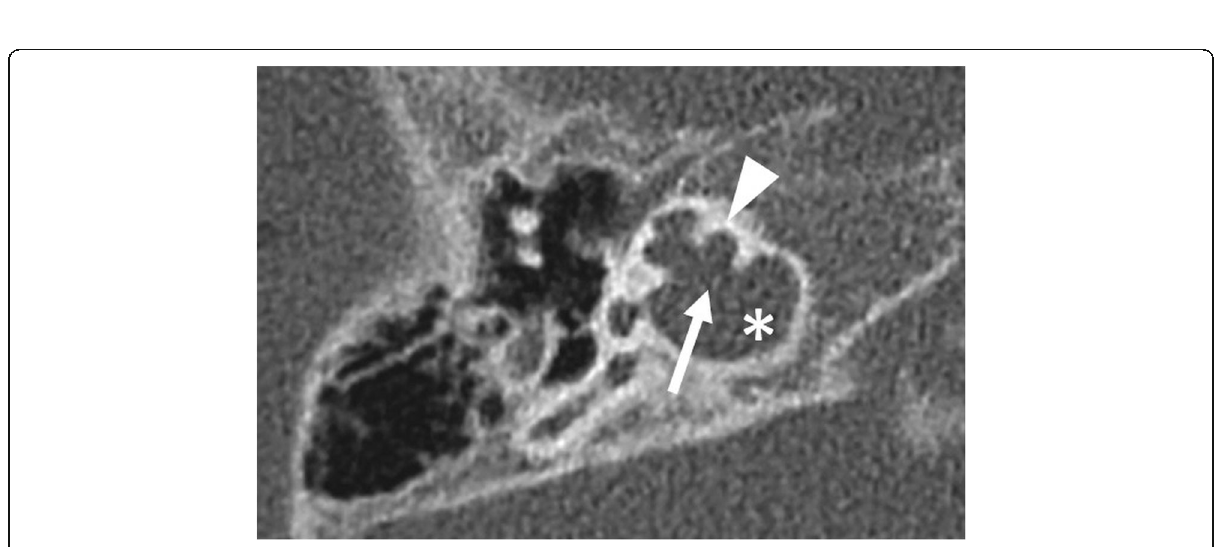
Fig. 10 A 1-year-old male patient, with bilateral severe SNLH from birth. HRCT axial image shows incomplete partition type III with empty cochlea with preserved interscalar septa (arrowhead). Modiolus and bony separation of the cochlea and internal auditory canal are absent (arrow). The cochlea is placed directly at the lateral end of the internal auditory canal